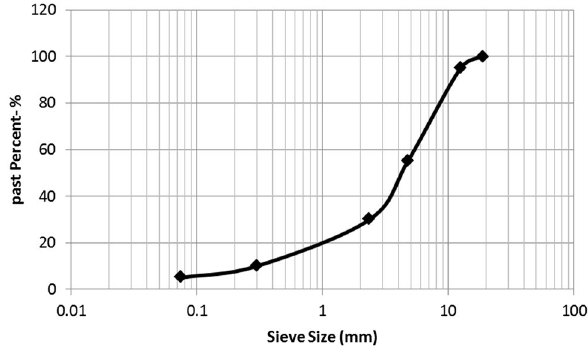
Fig. 1 Selected grading